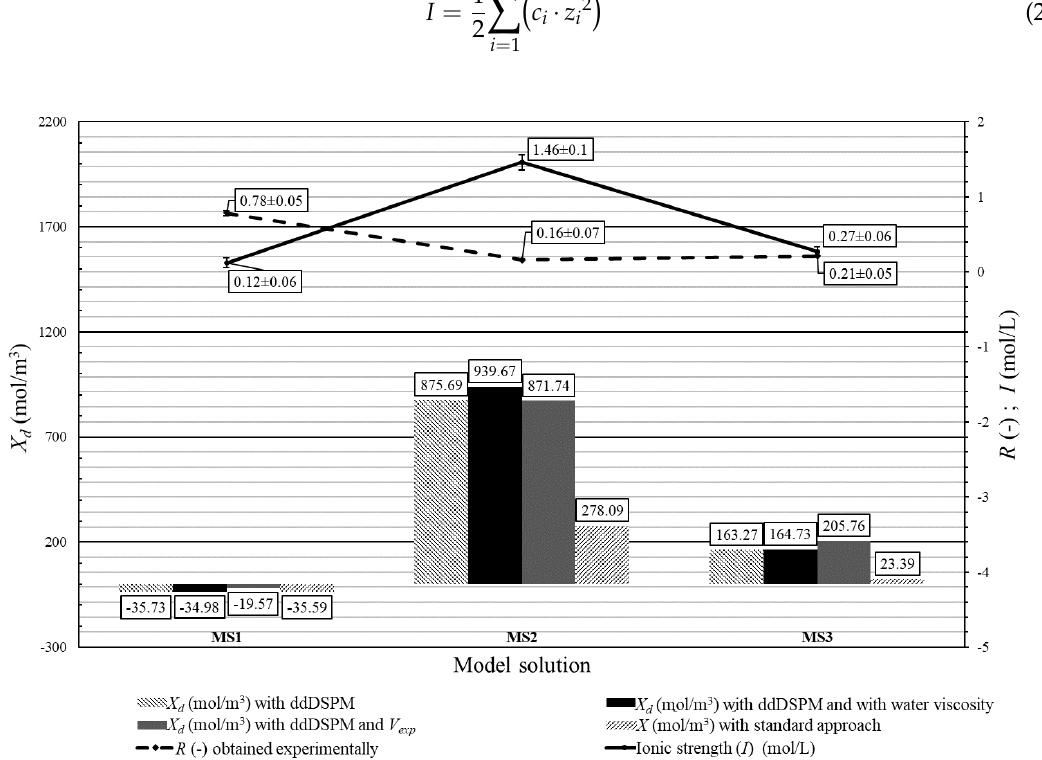
Figure 6. Comparison of estimated total volume membrane charge densities ( X d ) with different modeling approaches with relation to ionic strength ( I ) and experimentally obtained retentions ( R ) (ddDSPM — detailed described Donnan – Steric Partitioning Model; DSPM — Donnan – Steric Partitioning Model with standard approach; V exp — experimental volume flux).